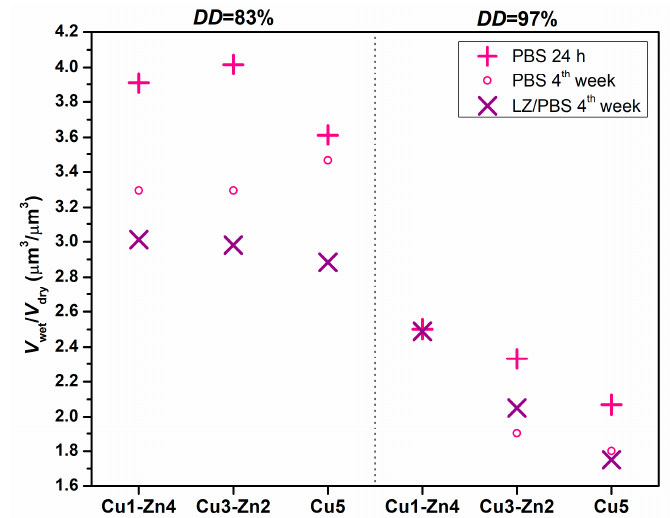
Figure 6. Volume ratio of bimetallic chitosan systems after immersion in phosphate-buffered saline so- lution (PBS, pH 7.4) or lysozyme/PBS solution, V wet , with respect to dry microgels, V dry . (Insufficient amount of Cu1-Zn4 DD 97 sample at 4 weeks in PBS for analysis).